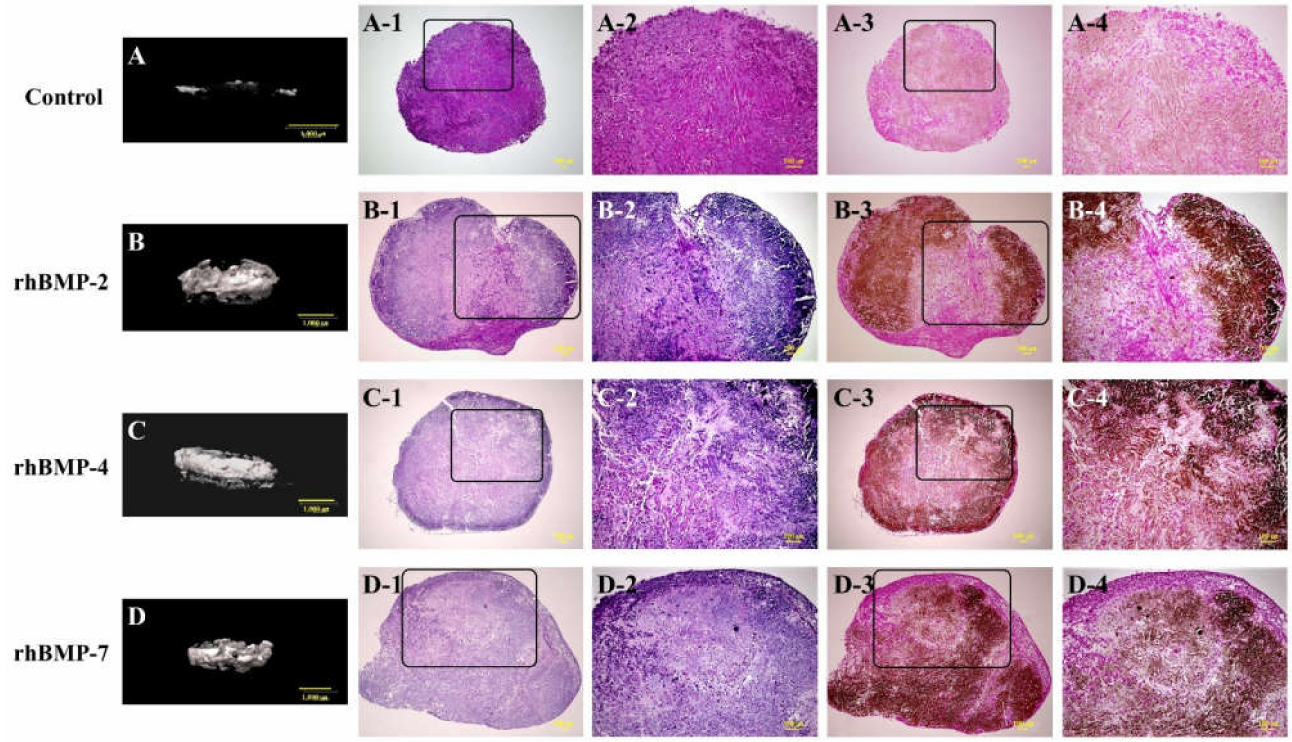
Figure 1. Typical micro-CT ( A – D ) and histological images of cultured immature muscular tissue (IMT), control (treated with 10 µ L of sterilized 4 mM HCl containing 0.2% BSA only) and treated with 10 µ L of each recombinant human bone morphogenetic protein (rhBMP)-2, rhBMP-4, and rhBMP-7. Samples were cultured for two weeks. A-1, -2, B-1, -2, C-1, -2, and D-1, -2 show hematoxylin and eosin (H&E) staining and A-3, -4, B-3, -4, C-3, -4, and D-3, -4 show von Kossa staining. A-2–D-2 and A-4–D-4 are magnified insert images of A-1–D-1 and A-3–D-3, respectively. Scale bar sizes in micro-CT and histological images are 1000 µ m and 100 µ m,